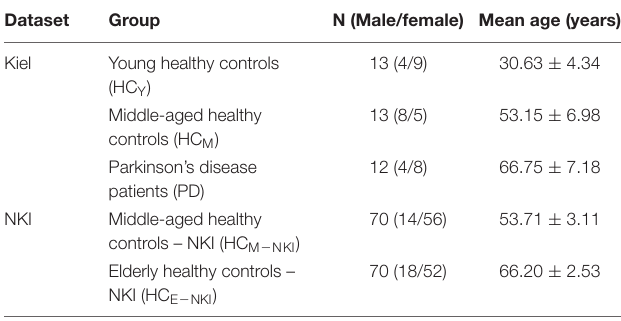
TABLE 1 | Demographics and group distribution.